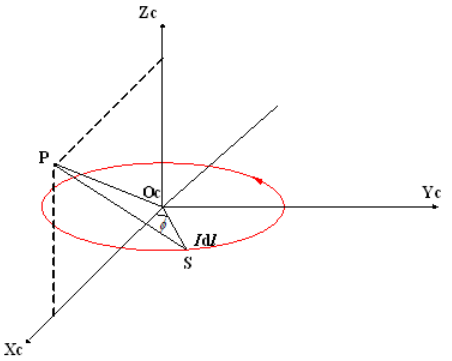
Figure 5. Analyzing on the magnetic field of a single turn circular